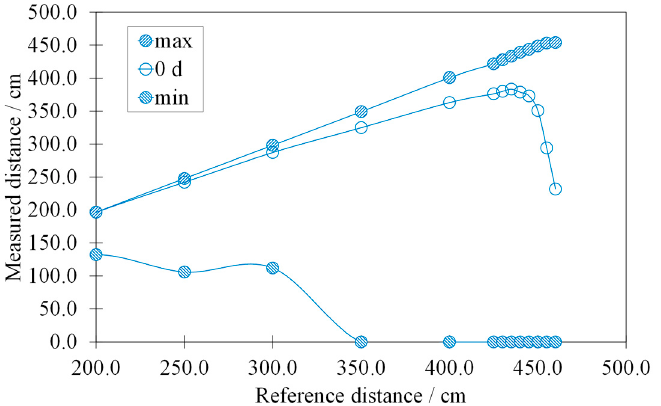
Figure 6. Calibration curve of the HY-SRF05, before the latter is subjected to the accelerated aging (0 d), with the curves of the maximum (max) and minimum (min) values.